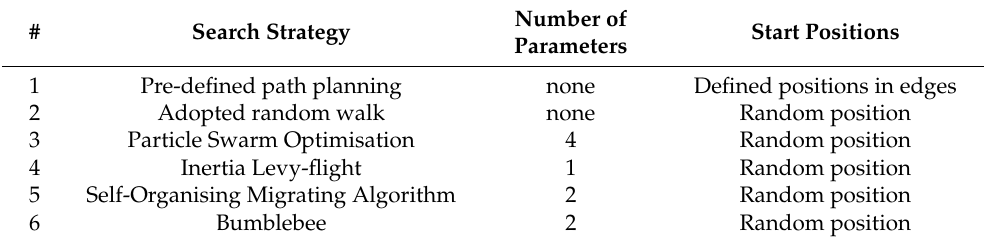
Table 1. Summarised search strategies for submarine groundwater discharge (SGD)